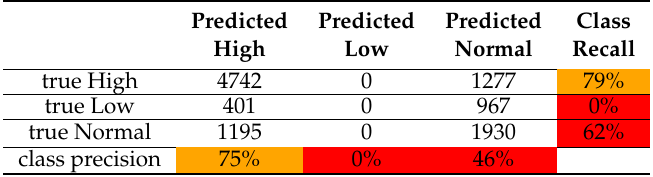
Table 1. Confusion matrix for NB.